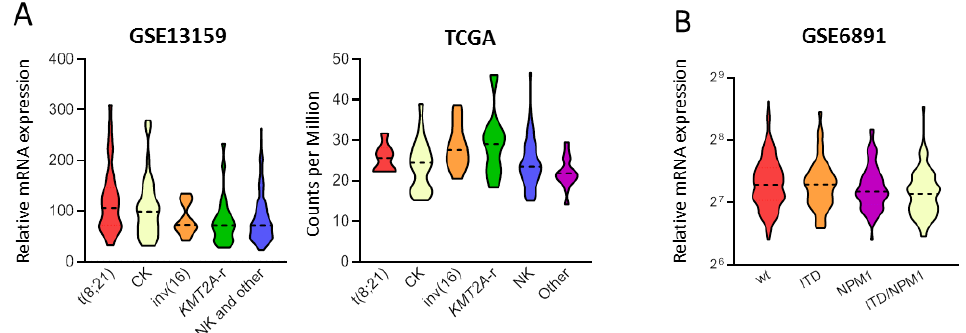
Figure 1. PPM1D expression in AML according to cytogenetic classification and FLT3 -ITD/ NPM1 status. ( A ) Violin plot of PPM1D transcript level in the GSE13159 and TCGA cohorts showing a significant different distribution among cytogenetic subgroups (t(8;21); CK: complex karyotype; inv(16): inv(16)/t(16;16); KMT2A -r: KMT2A -rearranged; NK: normal karyotype; AML carrying NK and other cytogenetics abnormalities could not be distinguished in GSE13159 due to data unavailability, thus named as “NK and other”). ( B ) Violin plot of PPM1D transcript level in the GSE6891 cohort showing a significant different distribution among molecular subgroups defined by FLT3 -ITD and NPM1 mutations (wt: FLT3 -ITD − / NPM1 -wt; ITD: FLT3 -ITD+/ NPM1 -wt; NPM1: FLT3 -ITD − / NPM1 -mut; ITD/ NPM1 : FLT3 -ITD+/ NPM1 -mut). The plots represent the frequency distribution of PPM1D levels (from minimum to maximum) and the dotted line indicates the median value (only cohorts showing statistically significant results are reported in the figure).